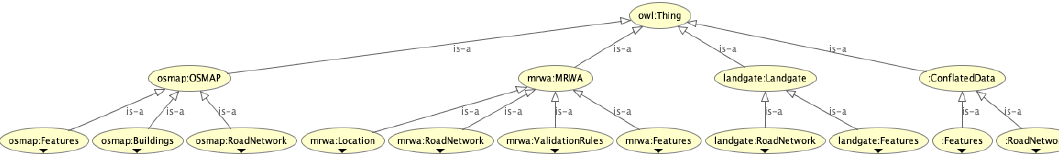
Figure 2. The ontology model is subdivided into the ontologies OSMAP, MRWA, Landgate and conflated data. Each ontology has has an individual structure and the illustration shows the first subclass of each ontology.